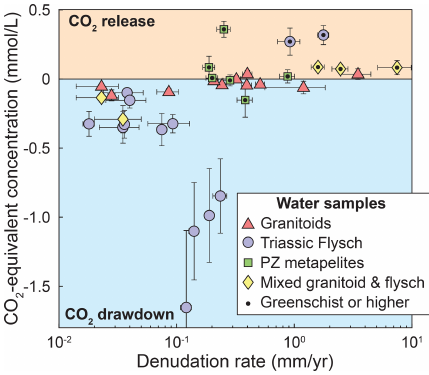
Figure 7. Influence of weathering on the carbon cycle. Equiva- lent concentration of CO 2 released or consumed. Symbols indicate catchment lithology. Catchments underlain by different lithologies are distinguished by symbols and color. Data points with a black dot are metamorphosed to greenschist facies or